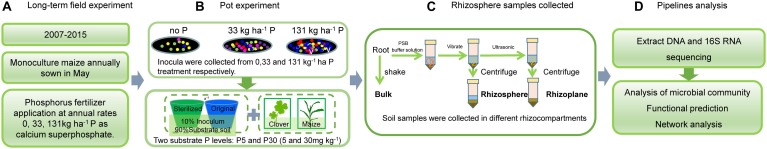
Flow diagram of the experiment.